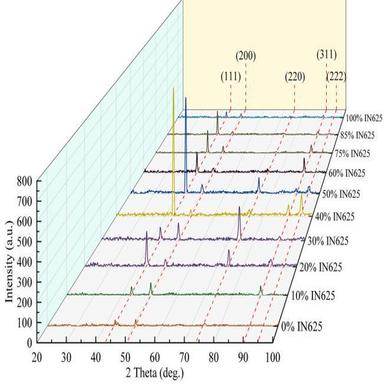
XRD diffraction patterns of the FGM in different positions.